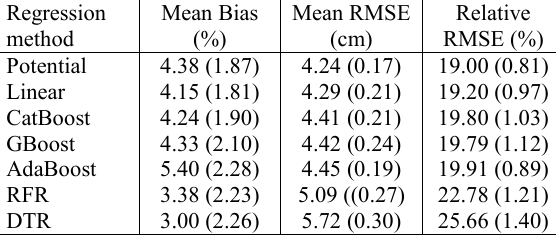
Figure 2 . Comparison between tree heights measured with a hypsometer (field work) and extracted from the image-based CHM. Red line refers to 1:1 line.